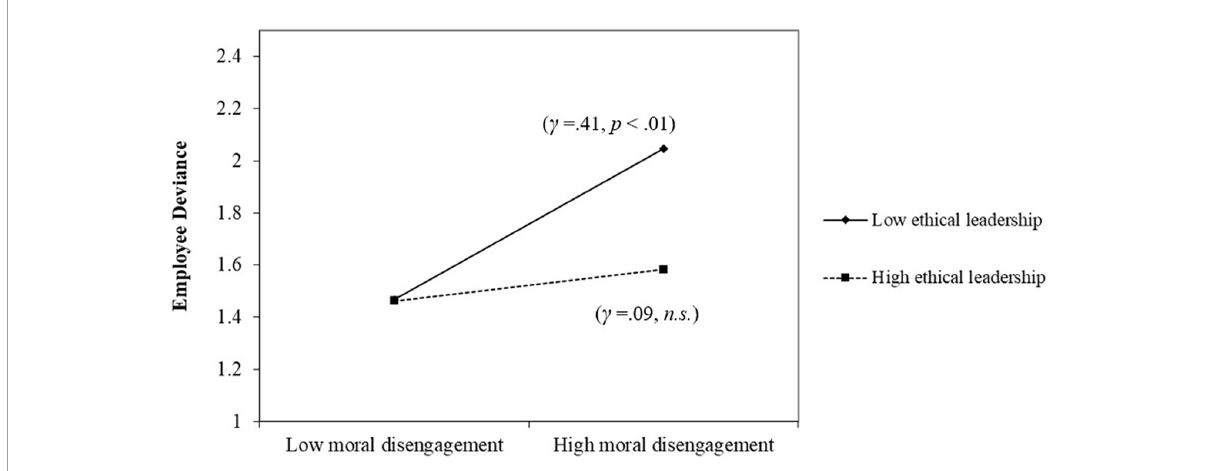
FIGURE2 The moderating effects of ethical leadership on the relationship between moral disengagement and